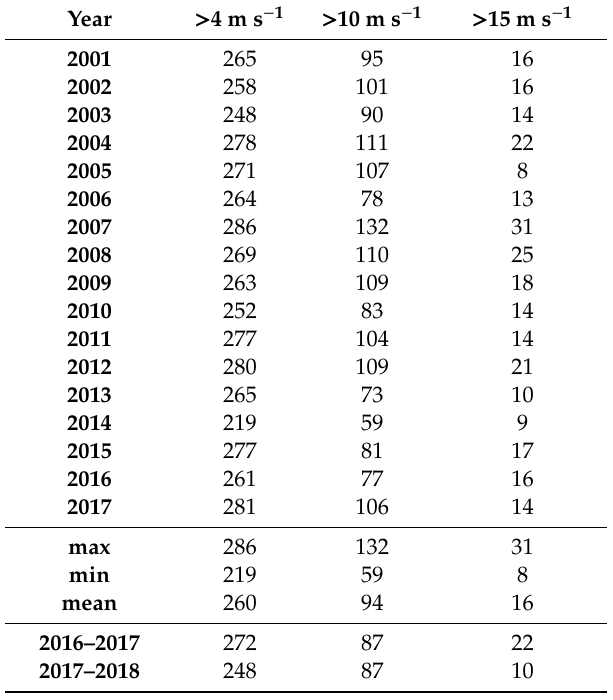
Table 1. Number of days with wind speeds allowing aeolian transport in 2001–2017.